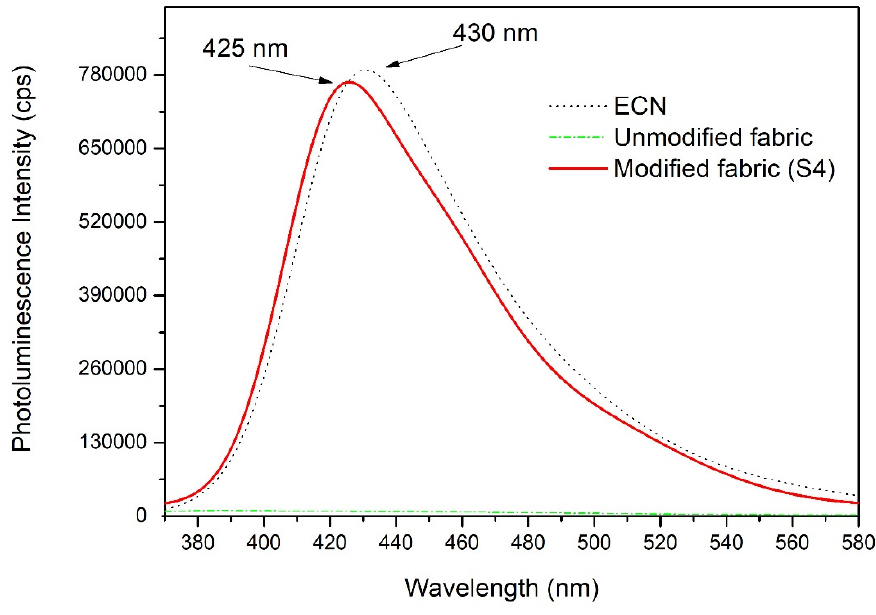
Figure 6. Photoluminescence spectra of the ECN, unmodified and modified S4 fabrics.